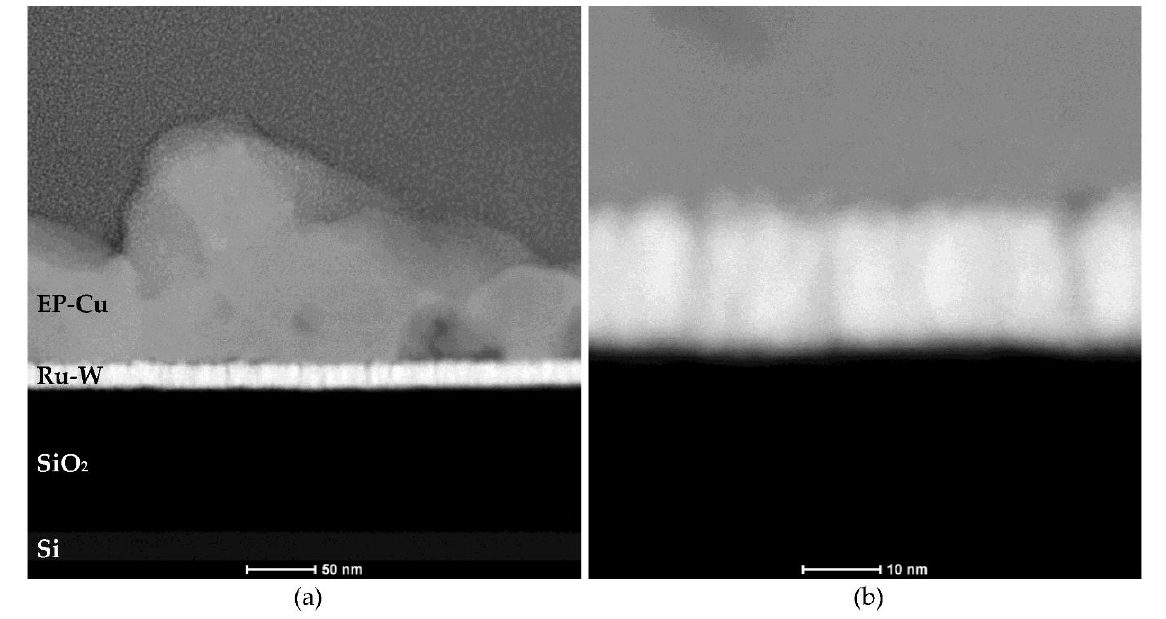
Figure 9. HAADF image of the Cu/Ru – W/SiO 2 /Si stack cross-section ( a ) and higher magnification of the same zone showing interfacial continuity between electroplated Cu film and Ru – W substrate ( b ).